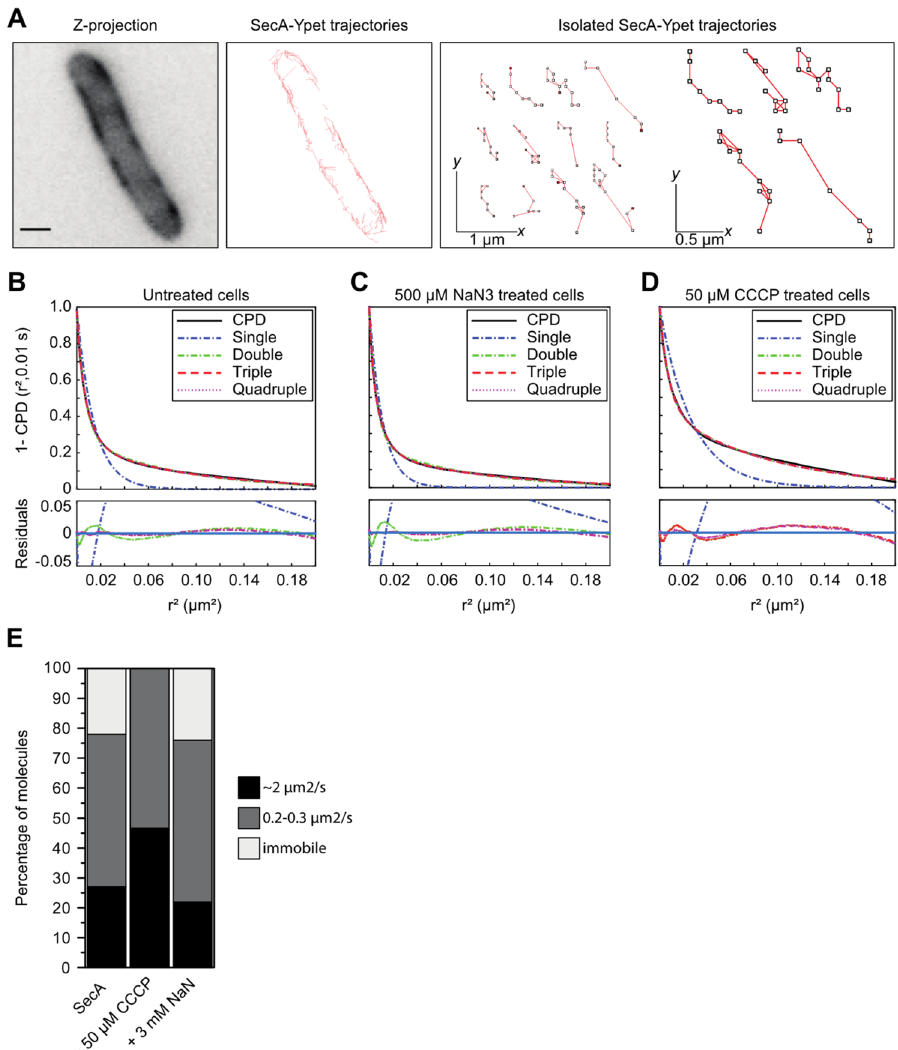
Figure 6. In vivo SecA-Ypet trajectories and diffusion curves. Scale bar is 1 µm. ( A ) Trajectories resulting from in vivo particle tracking display diffusion alongside the cytoplasmic membrane as well as static localization. ( B – D , CDF, solid black line) reveal multiple populations ( B – D , single, double and triple exponential CPD models, dashed lines) of different diffusion rates explaining the observed trajectories. CDF of untreated cells ( B ) and incubated with 3 mM NaN 3 ( C ) are best described by a triple exponential CPD model. Indicating three diffusive populations. ( D ) CDF of cells incubated with 50 µM CCCP fits best to a double exponential CPD model, indicating two diffusive populations. ( E ) In vivo SecA-Ypet diffusion rates under native and protein secretion impaired conditions. Stacked bar chart summarizing the diffusion rates obtained from the CPD analysis. Under native conditions and impaired SecA-mediated protein secretion (+ 3 mM NaN 3 ), three populations with comparable diffusion rates are observed. A significant change in the diffusive behavior of SecA is observed with the addition of 50 µM CCCP (+ 50 µM CCCP) as the immobile population is not detectable anymore. CPD indicates two populations